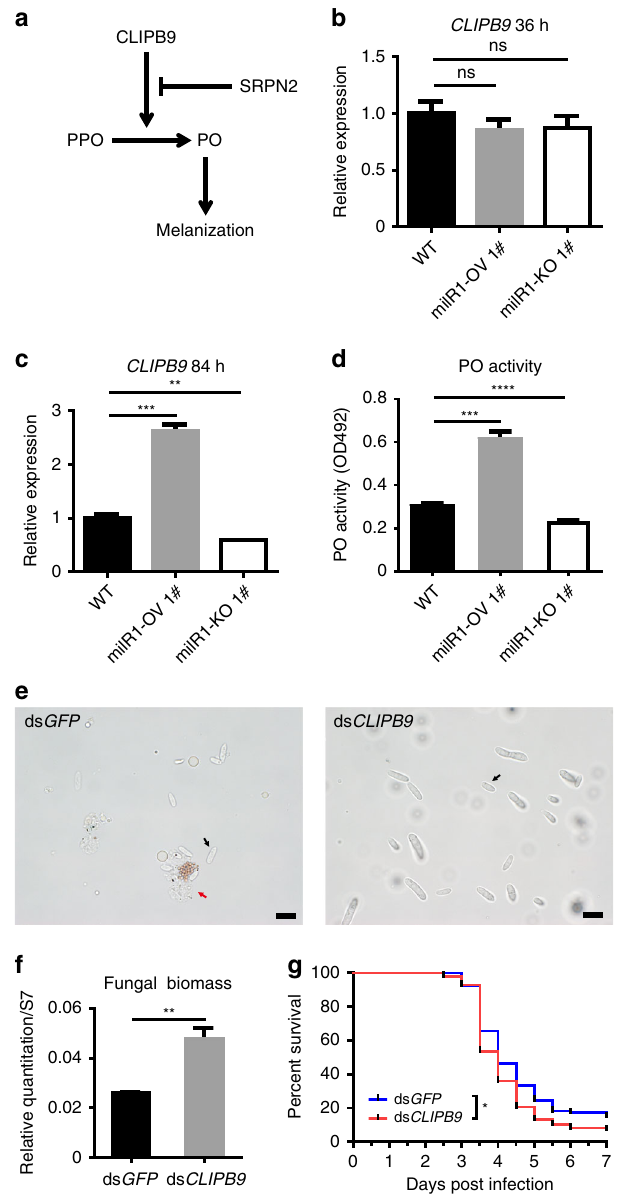
Fig. 5 The interaction of bba-milR1 with the target gene CLIPB9 . a Diagram of the mosquito melanization response. Clip domain serine proteinase: CLIPB9; Serine protease inhibitor: SRPN2; prophenoloxidase: PPO; phenoloxidase: PO. b The relative transcript levels of CLIPB9 in mosquitoes at 36 h post infection with WT, milR1-OV 1#, or milR1-KO 1# strains. There was no signi fi cant difference in CLIPB9 expression among the groups at this time point (Student ’ s t test). c The relative transcript levels of CLIPB9 in mosquitoes at 84 h post infection with WT, milR1-OV 1#, or milR1-KO 1# strains. The expression values are normalized to WT. d Infection of milR1- OV1# and milR1-KO 1# results in signi fi cant increase and decrease in A. stephensi hemolymph PO activity compared with WT at 84 h post infection, respectively. e Effect of CLIPB9 silencing on fungal hyphal body formation in the mosquito hemocoel at 60 hpi. The black arrows and red arrow indicate the hyphal bodies and mosquito hemocyte, respectively. Scale bars, 10 μ m. PO activity f qPCR-based quanti fi cation of fungal load in mosquitoes injected with dsGFP or dsCLIPB9 at 60 hpi. Fungal levels are expressed as that of fungal 18S rRNA relative to A. stephensi ribosomal protein S7 (AsS7) DNA. g Effect of CLIPB9 silencing on the survival of mosquitoes following topical application of a suspension of 10 7 conidia/ml of B. bassiana ARSEF252 (Log- rank test). Values are mean ± s.e.m. Similar results were obtained in three biological repeats. * P < 0.05, ** P < 0.01, *** P < 0.001. P- value < 0.05 was regarded as statistically signi fi cant (Student ’ s t test). Source data are provided as a Source Data fi